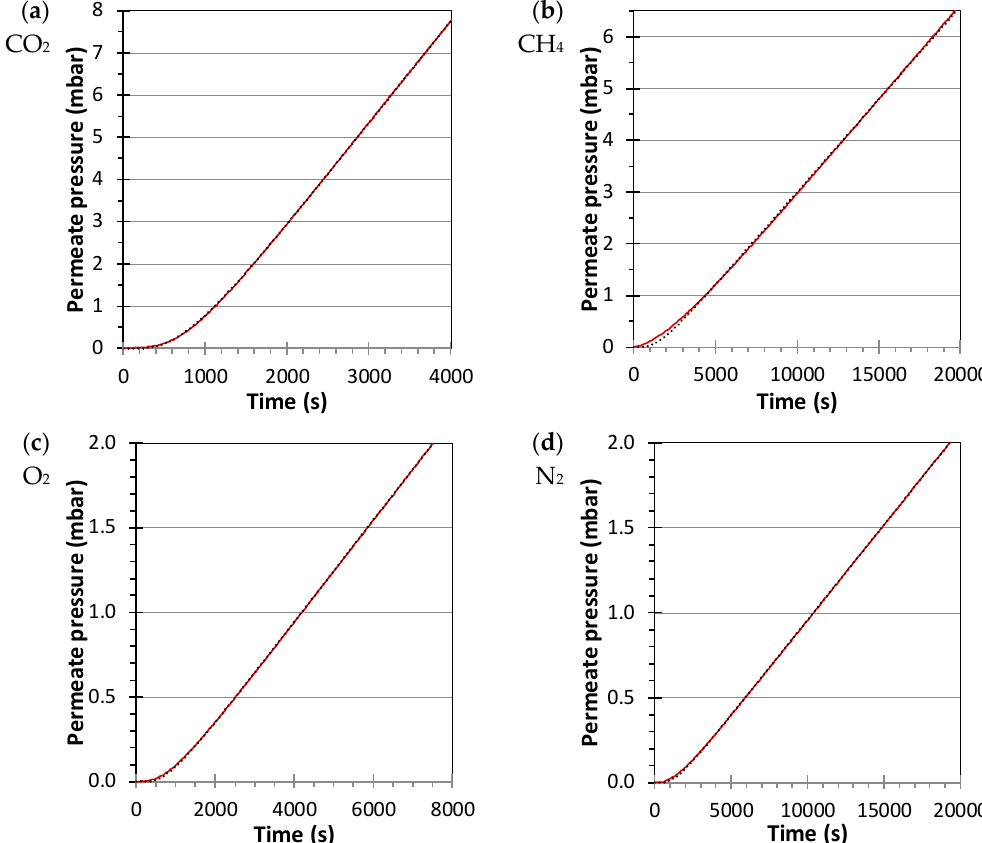
Figure 4. Permeation curve in the Pebax ® 1657/Cu II2 (S,S)-hismox·MMM (mixed matrix membrane) at 1.2 bar and 25 °C for ( a ) CO 2 ; ( b ) CH 4 ; ( c ) O 2 ; ( d ) N 2 ; and their fits in dotted black lines using Equation (4).